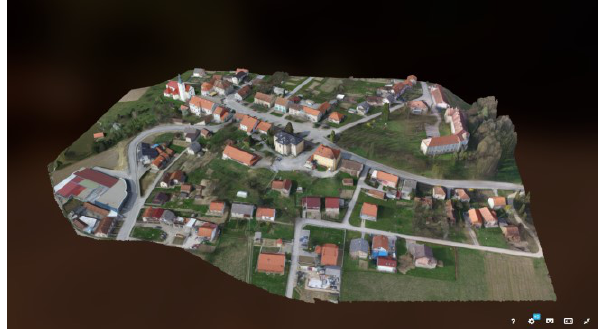
Figure 3. Photorealistic 3D model of Začretje published on Web (Gorički